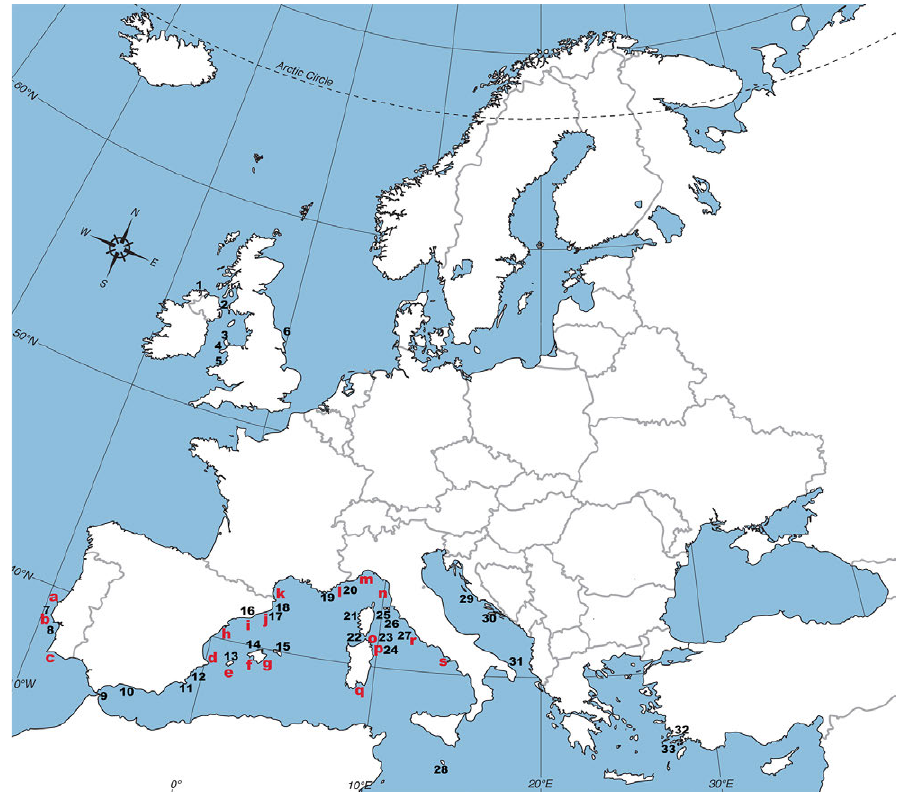
Fig. 7. – Map of the known records of C. elegans and F. quatrefagesi based on a critical analysis of photographs published in various websites and in papers, and on personal observations as indicated in Supplementary Material Table S1 (letters in red refer to F. quatrefagesi and numbers in black to C. elegans